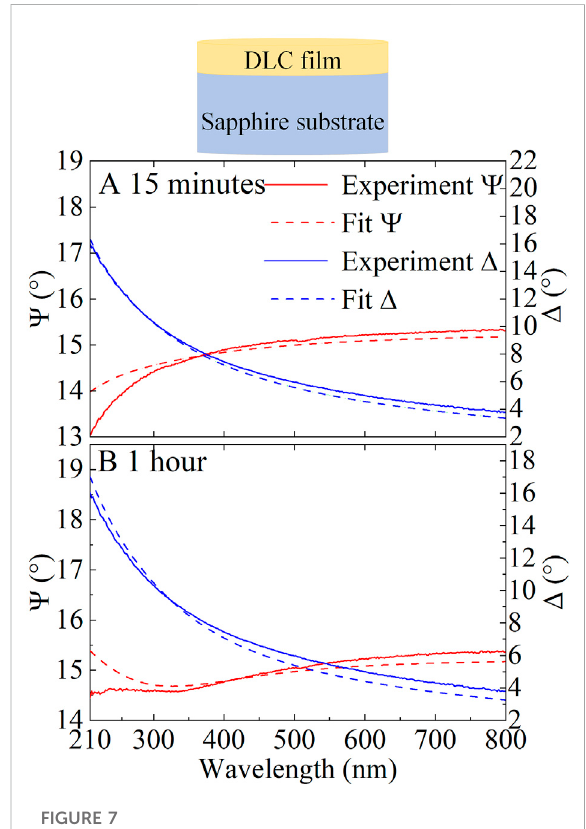
FIGURE 7 Ψ and Δ spectrameasuredat70 ° (A) the15 minsampleand (B) the 1 h sample. The simulated data corresponding with one single EMA model are also included.